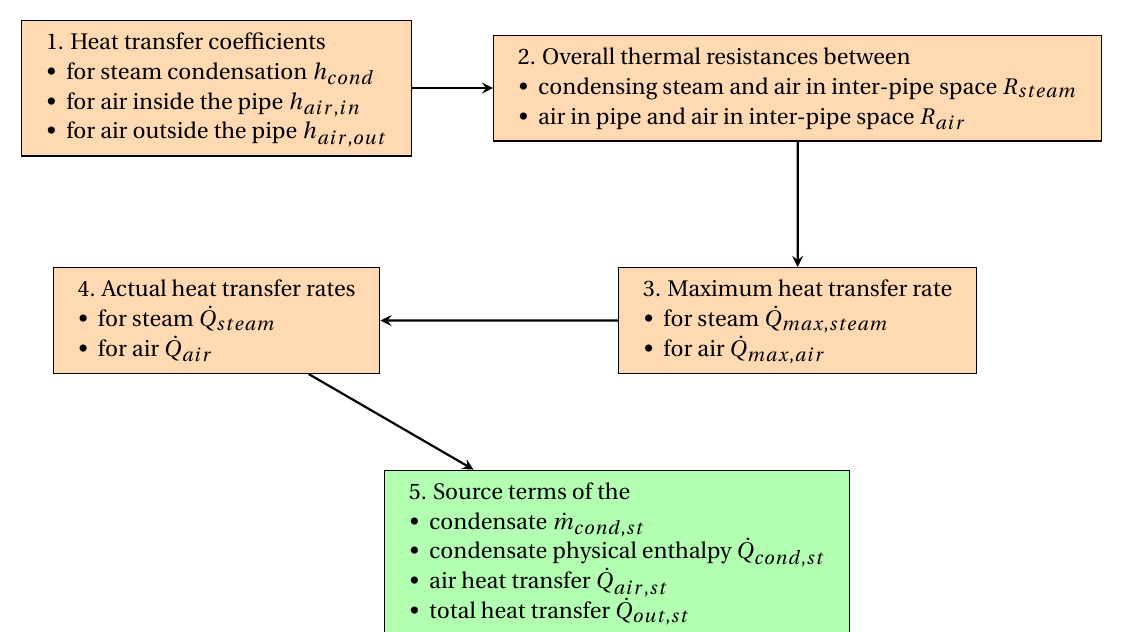
Figure 4. Schematic algorithm of the developed condensation and heat transfer model within developed UDF. Detailed description of the species transport model, momentum, and energy